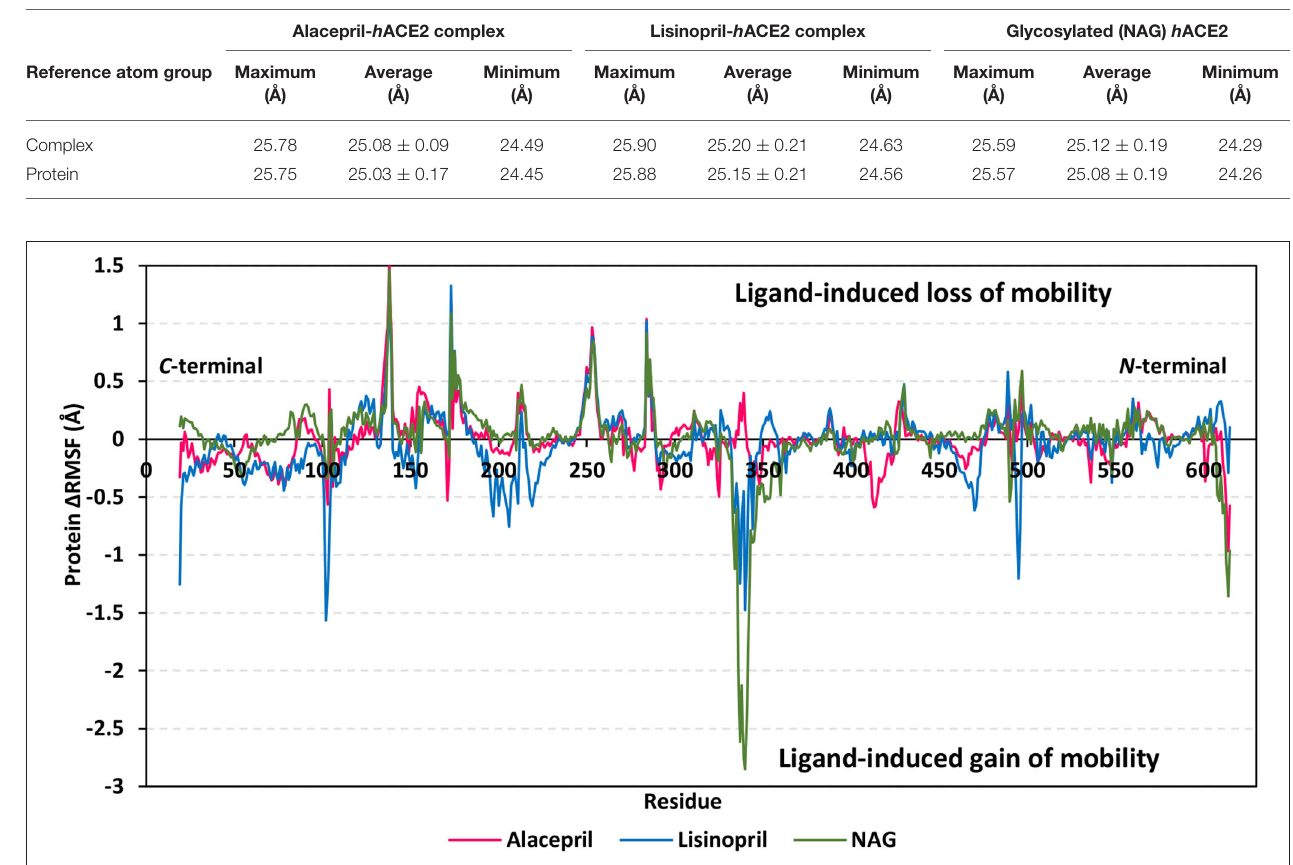
FIGURE 6 | Relative 1 RMSF analysis of ligand- h ACE2 protein complexes throughout 100 ns all-atom MD simulation. Protein backbone 1 RMSF trajectories were determined from the independent MD-simulated h ACE2 apo-state against the complexed protein with alacepril, lisinopril, or NAG, which were shown as a function of residue number 19-to-619. Alacepril/ h ACE2, lisinopril/ h ACE2, and glycosylated (NAG)/ h ACE2 complexes are illustrated in red, blue, and green colors,